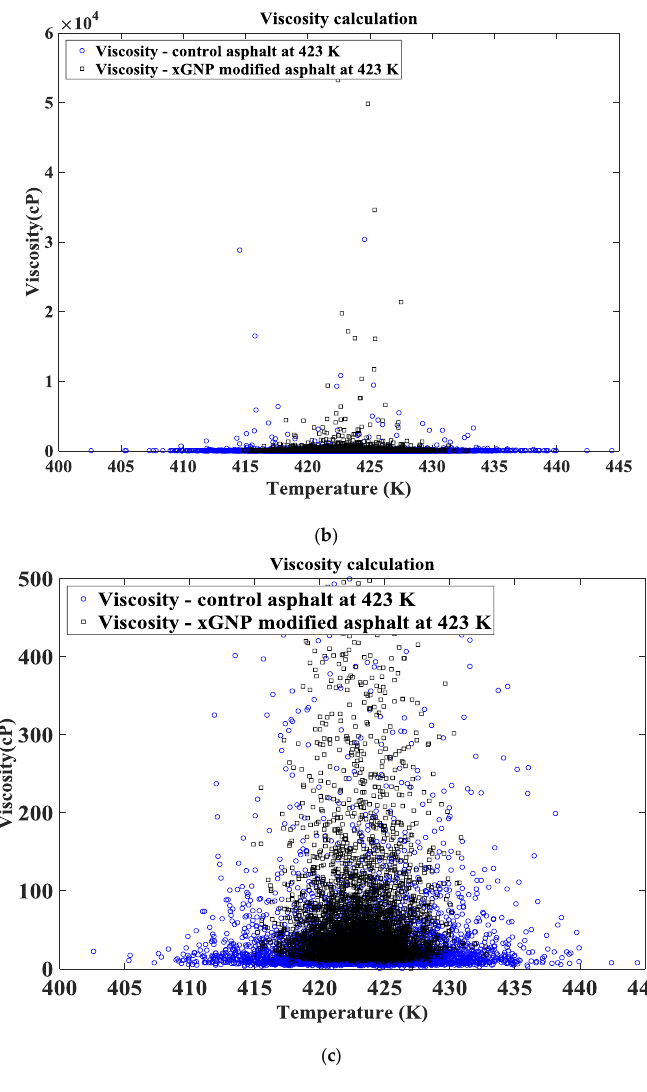
Figure 6. Viscosity test and MD calculation for the control and xGNP modified asphalt systems. ( a ) Momentum transferred in the control and xGNP modified asphalt binder systems at the temperature of 443 K; ( b ) Viscosities of the control and xGNP modified asphalt binder systems at the temperature of 423 K; ( c ) Viscosities (from 0 to 500 cp) of the control and xGNP modified asphalt binder systems at the temperature of 423 K.